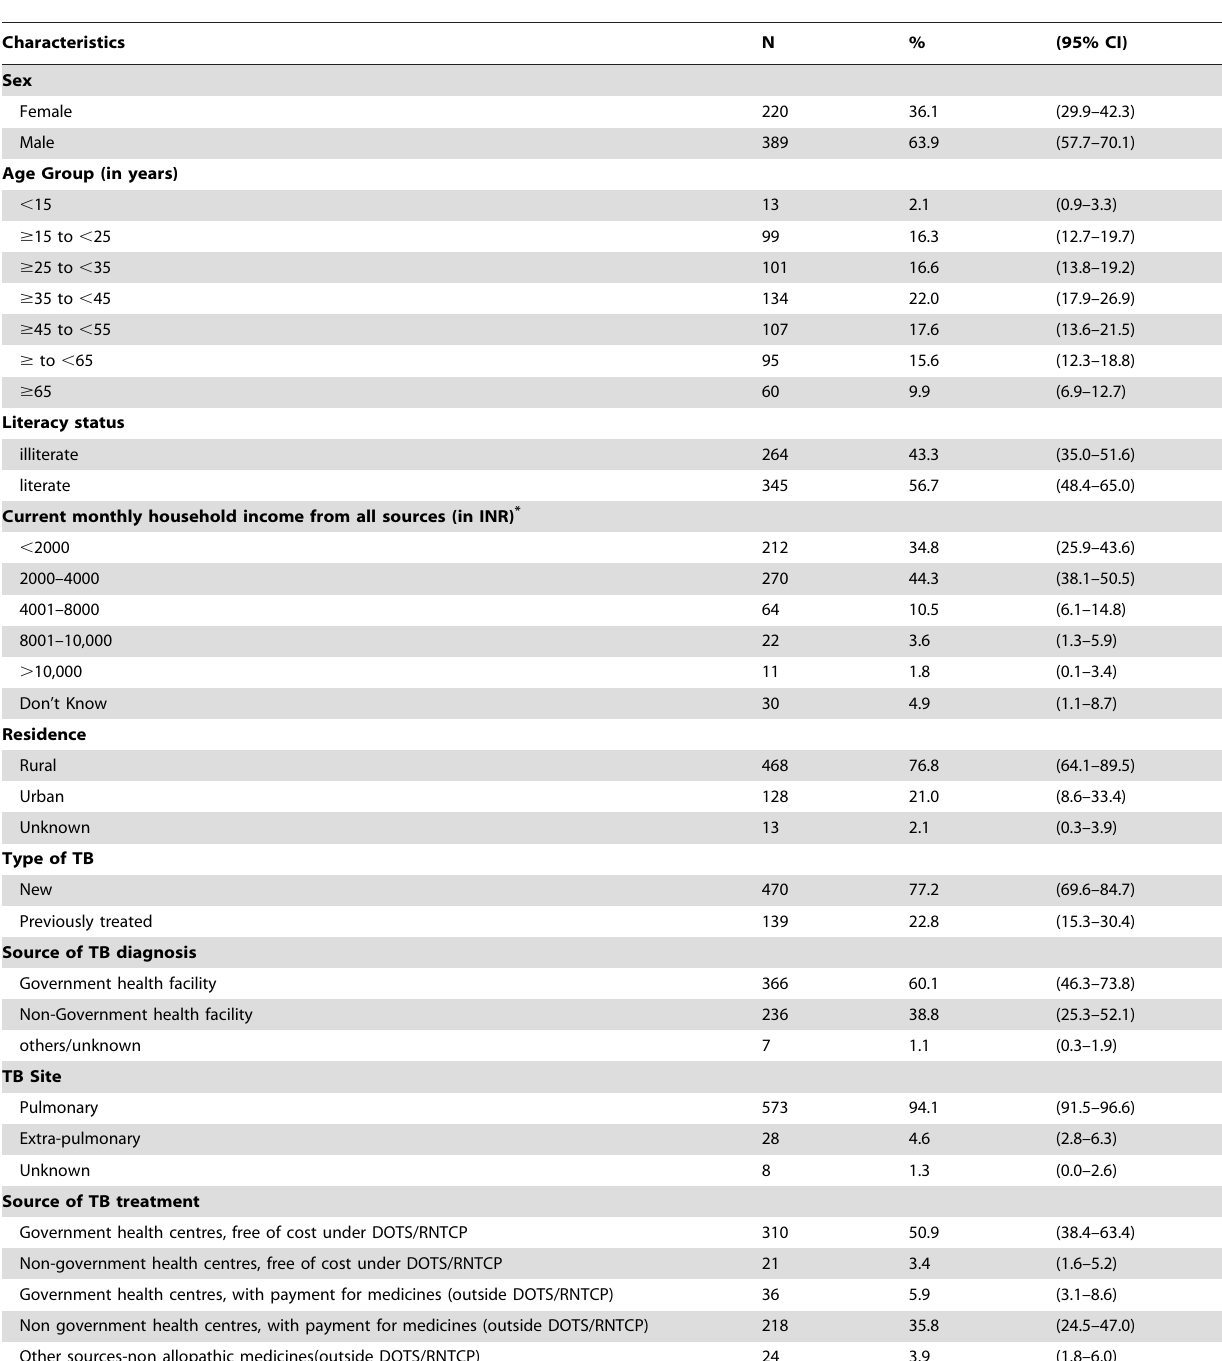
Table 2. Characteristics of self reported TB patients in a community based survey in India, 2011 (n= 609).